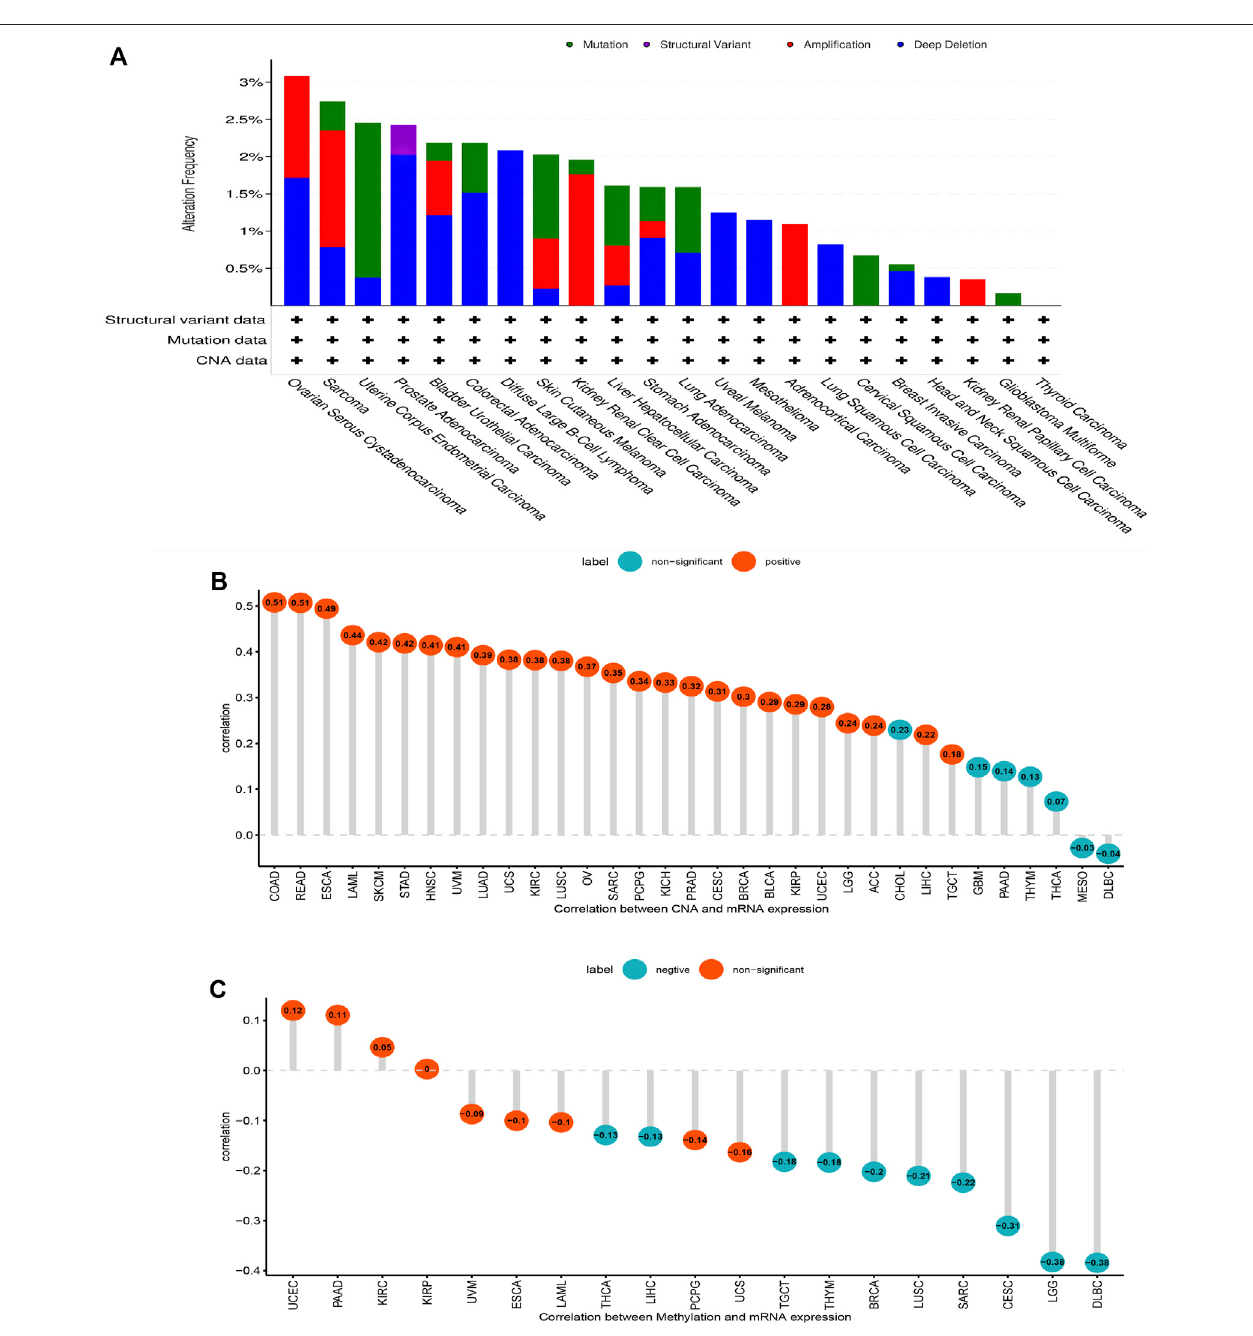
FIGURE3| GenealterationofAP3S1. (A) ThemutationandCNAstatusofAP3S1inTCGA-pan-cancer. (B) ThecorrelationbetweenAP3S1expressionandCNA. (C) The correlation between AP3S1 expression and DNA methylation.